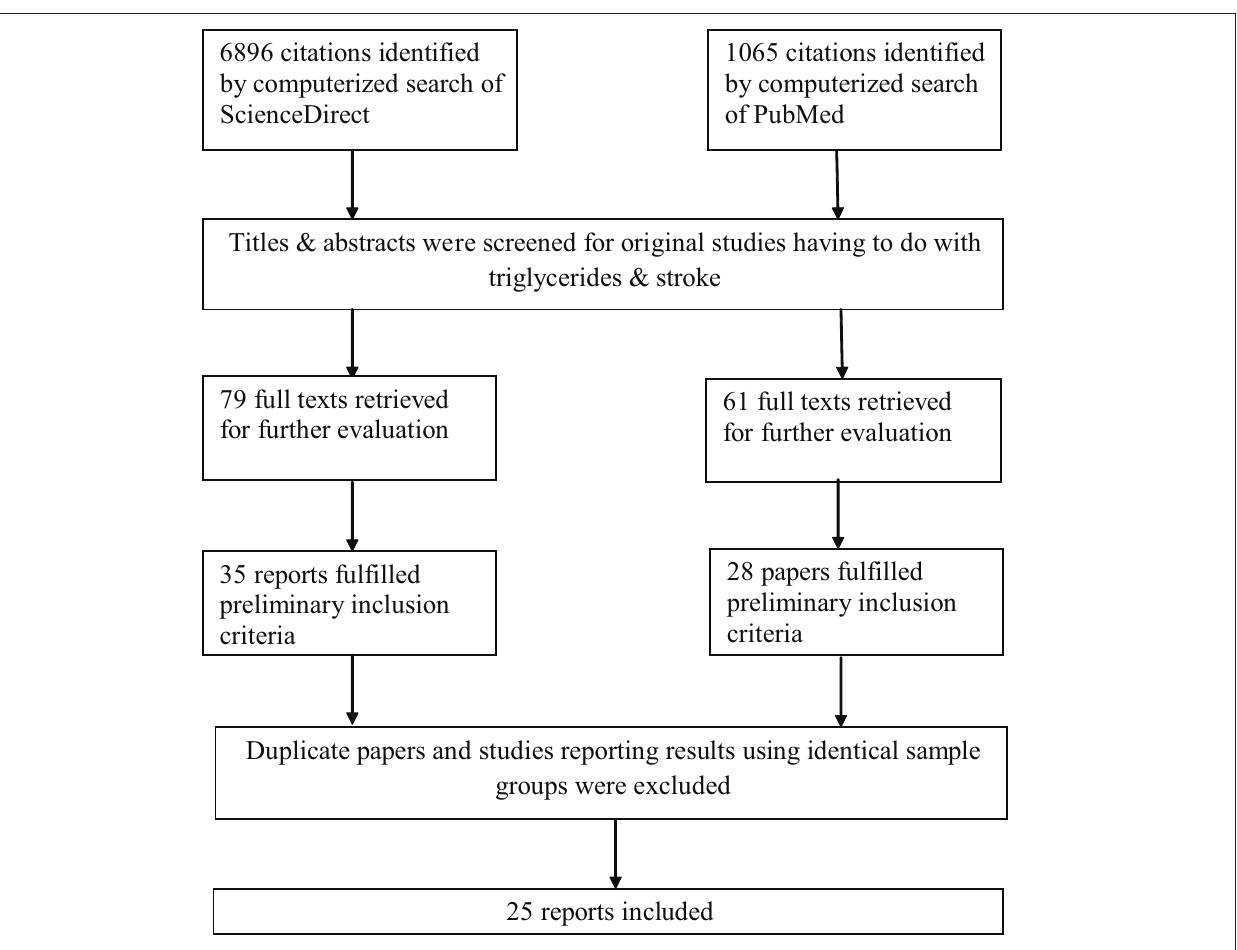
FiguRe 3 | Flow diagram outlining the study inclusion process. MESH terms: “triglycerides” plus